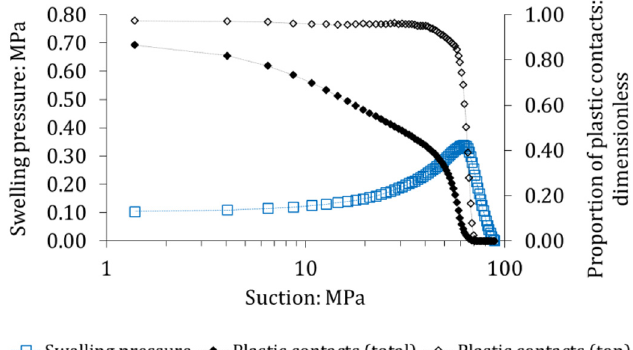
Fig. 7. Evolution of the proportion of plastic contacts and swelling pressure upon suction decrease in the simulated samples.